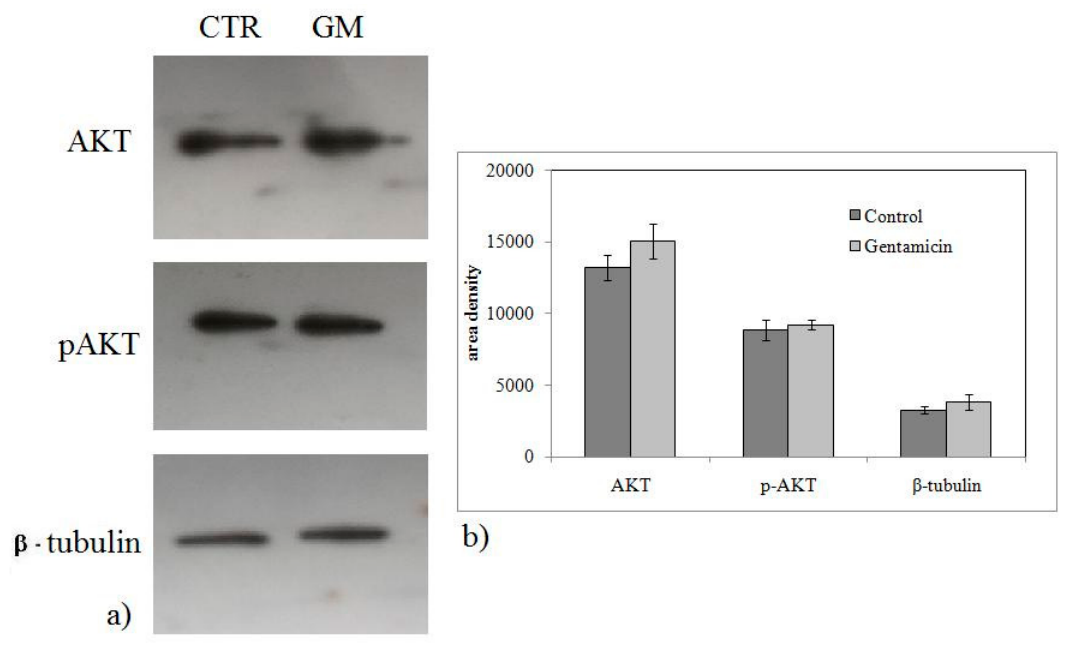
Figure 5. E ff ect of gentamicin on AKT / p-AKP protein expression. Experiments were performed in control and experimental NCI-N87 cells collected 24 h after 1.5 mM GM treatment. ( a ) Immunoblots of proteins were probed with anti-AKT and p-AKT and visualized by enhanced chemiluminescence (ECL). β -tubulin was used as loading control. ( b ) The area density was evaluated by densitometry scanning and analysis with ImageJ program, the data represent the mean ± SD of three experiments performed in duplicate (significance, * p < 0.001 versus control sample).